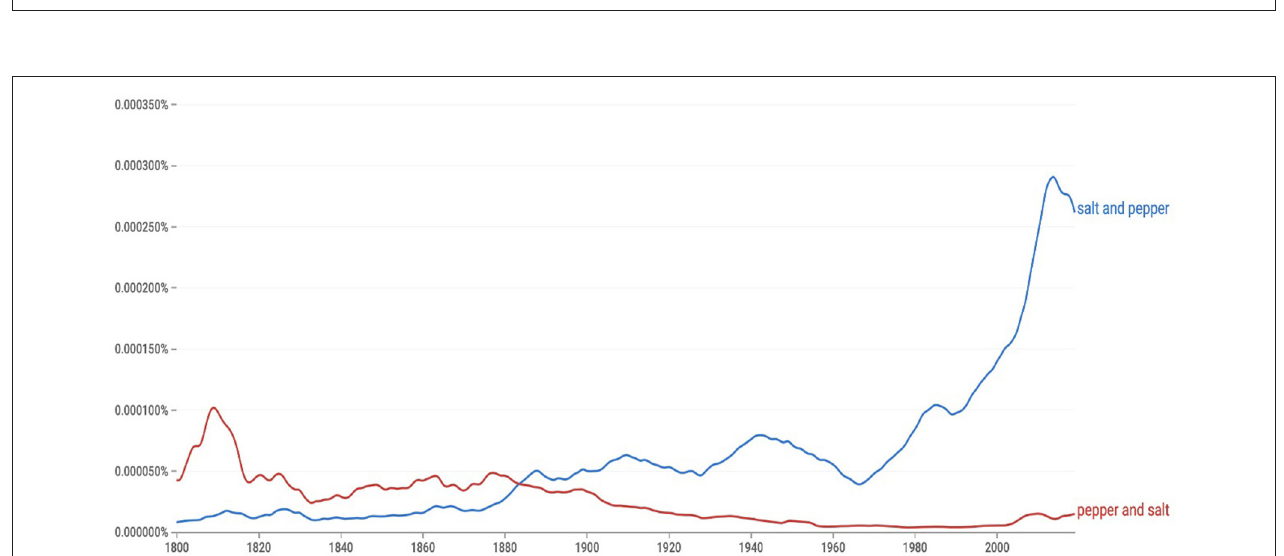
Frontiers in Psychology |